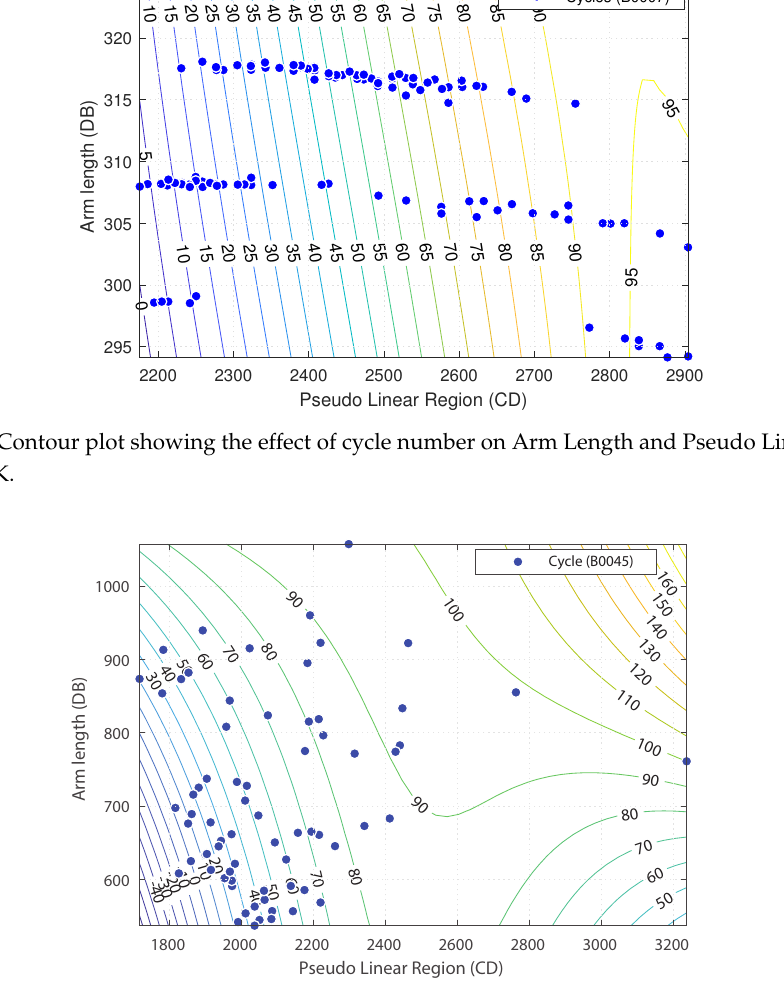
Figure 9. Contour plot showing the effect of cycle number on Arm Length and Pseudo Linear Region at 277.15